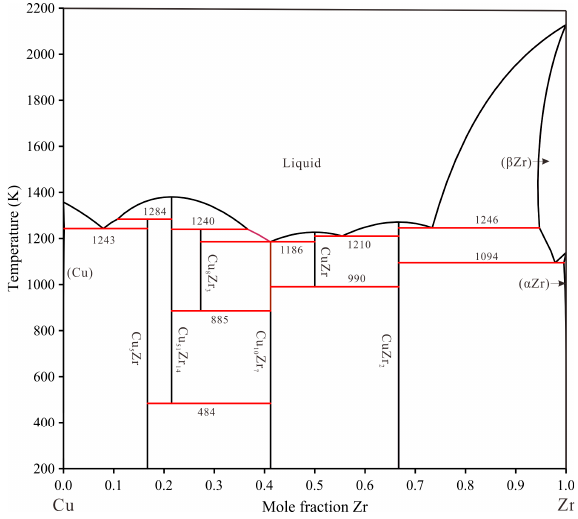
Figure 1. Calculated Cu–Y phase diagram using the parameter from Fries et al. [20] and this work.